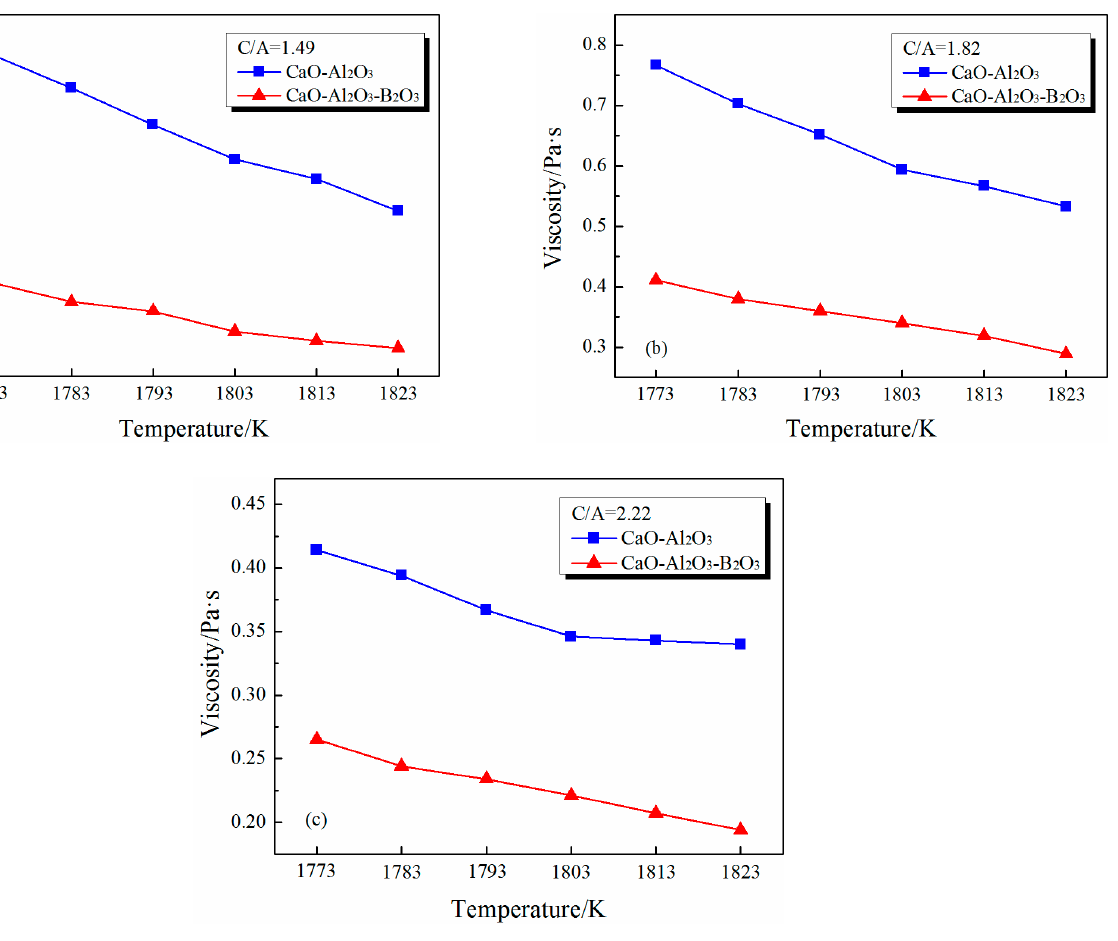
Figure 9. Effect of B 2 O 3 addition on the viscosity of CaO–Al 2 O 3 systems: ( a ) CaO/Al 2 O 3 mole ratio = 1.49; ( b ) CaO/Al 2 O 3 mole ratio = 1.82; ( c ) CaO/Al 2 O 3 mole ratio =